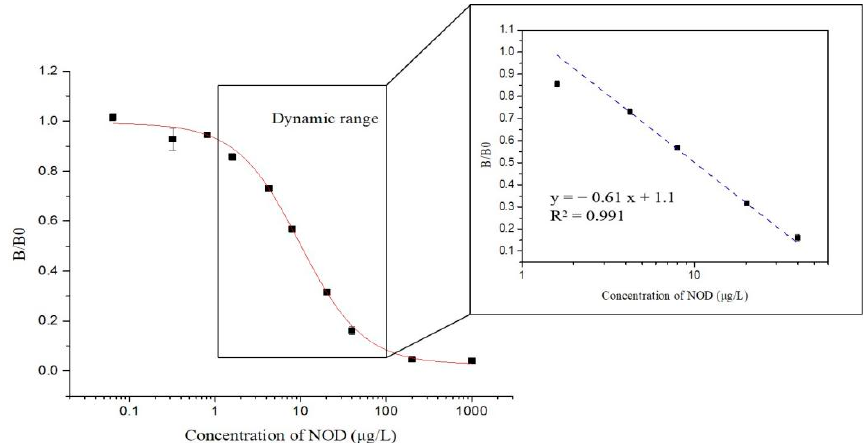
Figure 6. Optimization of assay conditions for the establishment of ic-ELISA: ( a ) types of buffers (PB, PBS, PBST, Tris-HCl, and HEPES), ( b ) pH value (6.5, 7.0, 7.5, and 8.0), and ( c ) ionic strength (5 mM, 10 mM, 20 mM, and 40 mM PBS). The conditions were evaluated by the Amax (maximal ab- sorbance)/IC 50 ratio.